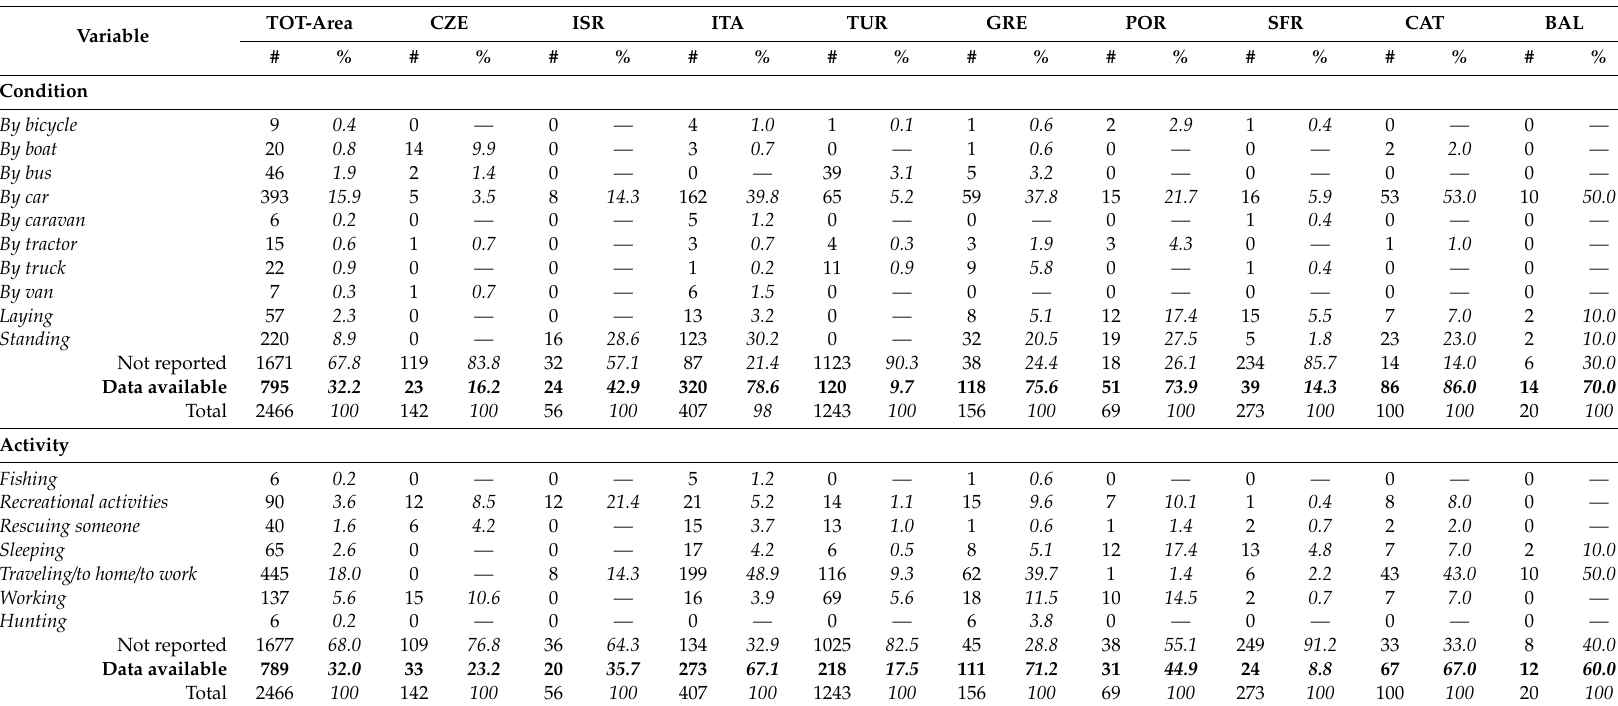
Table A3. EUFF Database: Condition and Activity of fatalities per TOT-A, and per each SA (#: Number; %: Percentage). Data available are in bold and percentage in